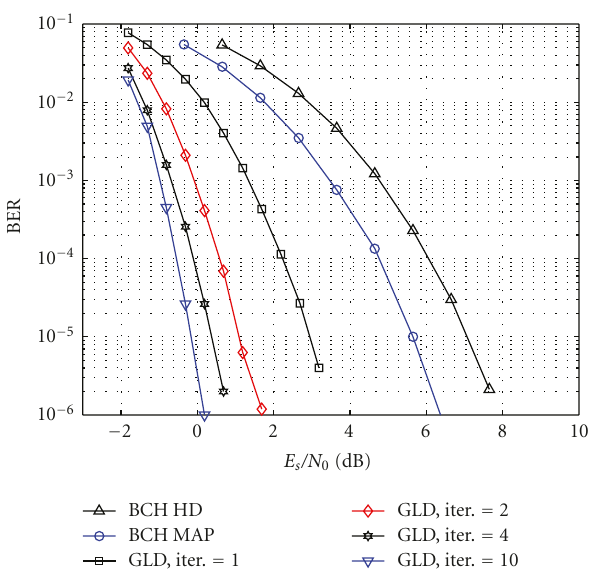
Figure 5: Performance of the progressive decoding at relays over AWGN